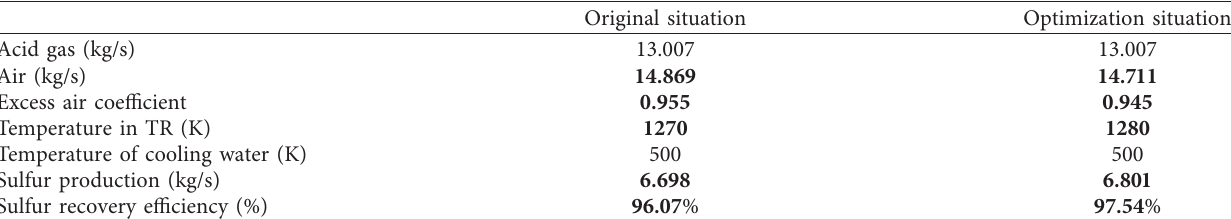
Figure 13: The display screen of the central controller in the Puguang gas field (test situation). Table 5: Original industrial data and the optimization